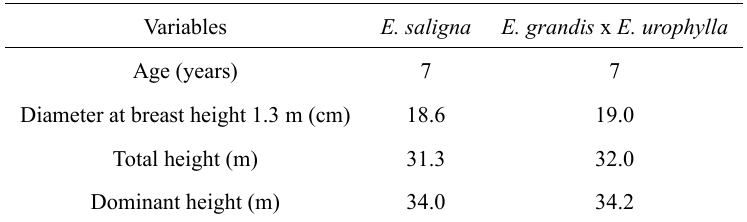
Mean characteristics of E. saligna and E. grandis × E. urophylla stands.